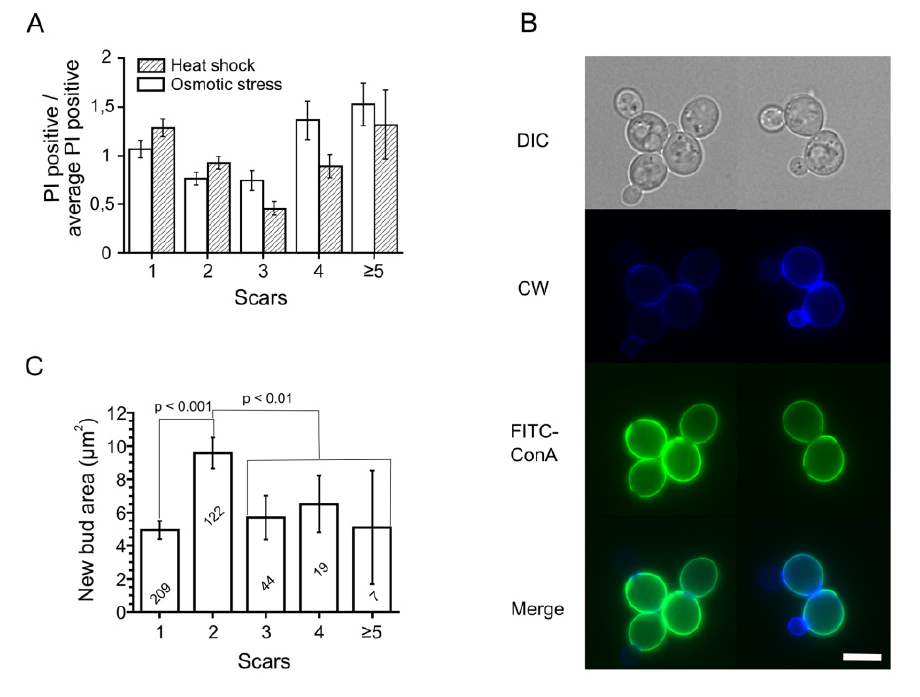
0.01 for all treatments, Microscopy and quantifica- exact numbers of cells